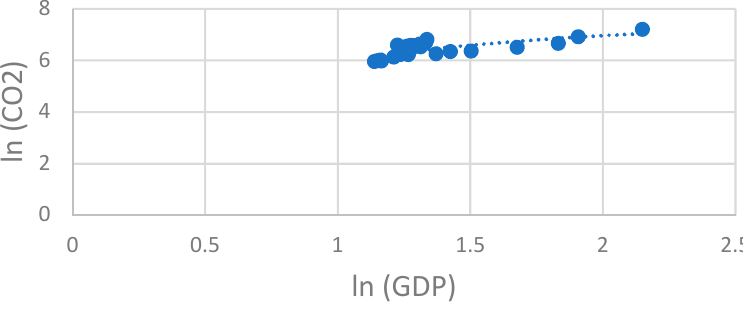
Figure 5. Environmental Kuznets curve (EKC) for carbon emissions and economic growth in Eastern European countries. Source: Authors’ calculations.